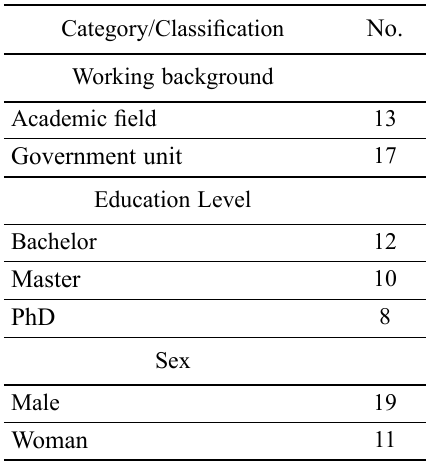
Table 2. Background information of